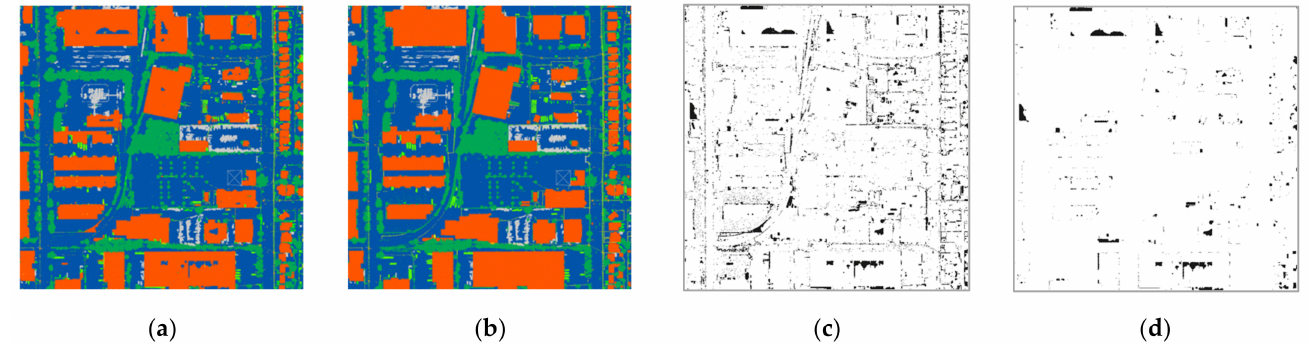
Figure 19. Results of semantic segmentation of test data 2 for Case 1: ( a ) prediction; ( b ) ground truth (i.e., label data); ( c ) difference between prediction and ground truth for all classes; ( d ) difference between prediction and ground truth for building class only.